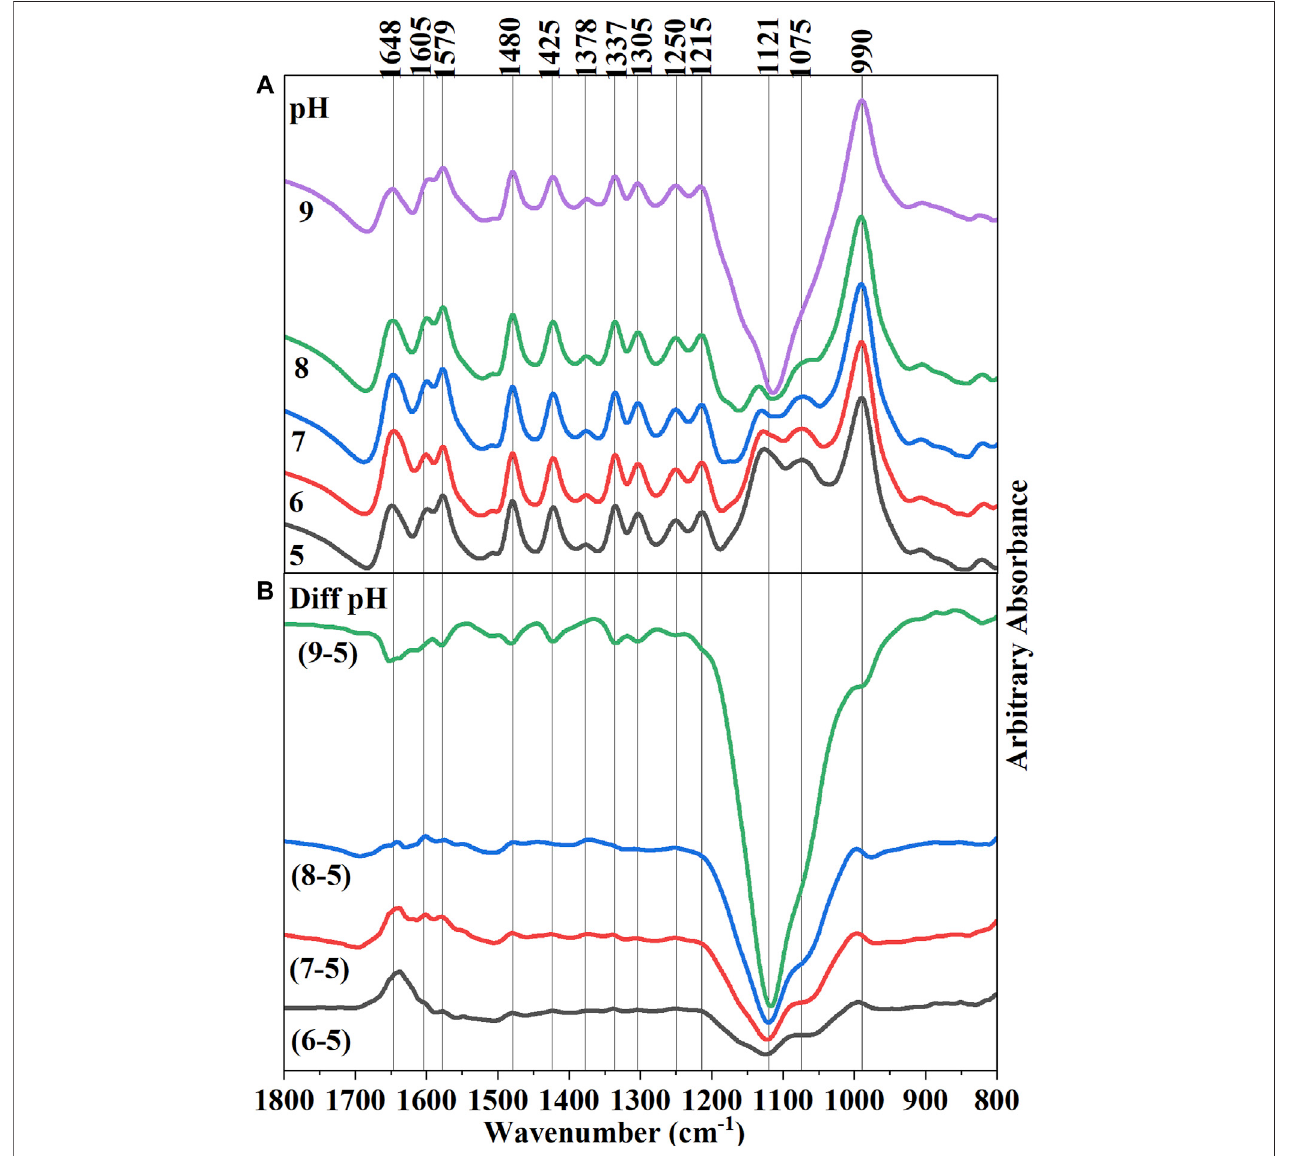
FIGURE2|(A) (Upper Panel)Finalequilibrated insitu ATR-FTIRspectraof10 µMadsorbedAMPonhematiteatpH5 – 9.Rawspectrawerestackedoneachother to visually observe the differences in IR bands, including the absorbance value. (B) (Lower Panel) Difference spectra of subsequent pH increments obtained from subtracting pH 5 spectrum form all other spectra. Thus, Diff pH (9 – 5) means pH 5 spectrum was subtracted from the fi nal equilibrated adsorbed AMP spectrum on hematite at pH